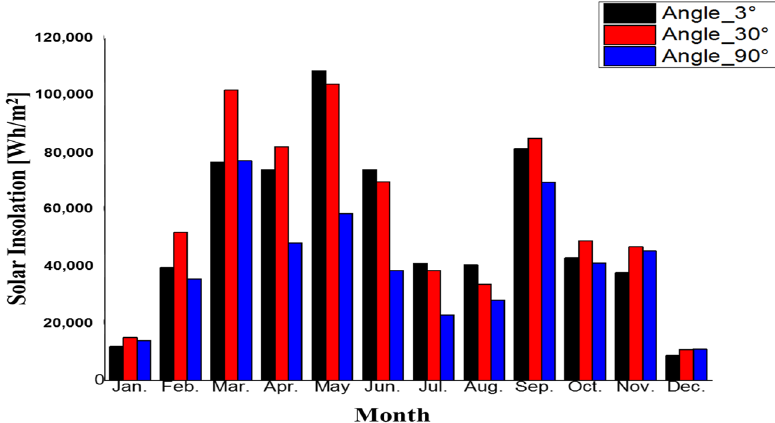
Figure 12. Monthly cumulative insolation for di ff erent installation angles (3 ◦ , 30 ◦ , and 90 ◦ ).